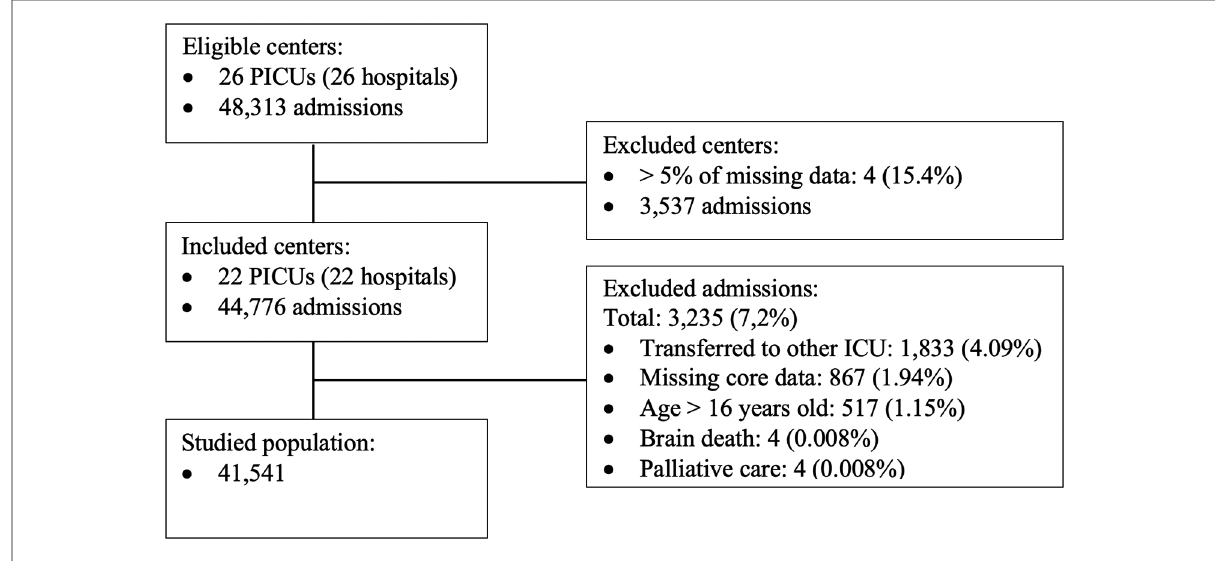
FIGURE 1 Study fl owchart, showing eligibility, exclusion criteria, and fi nal population included in the study.